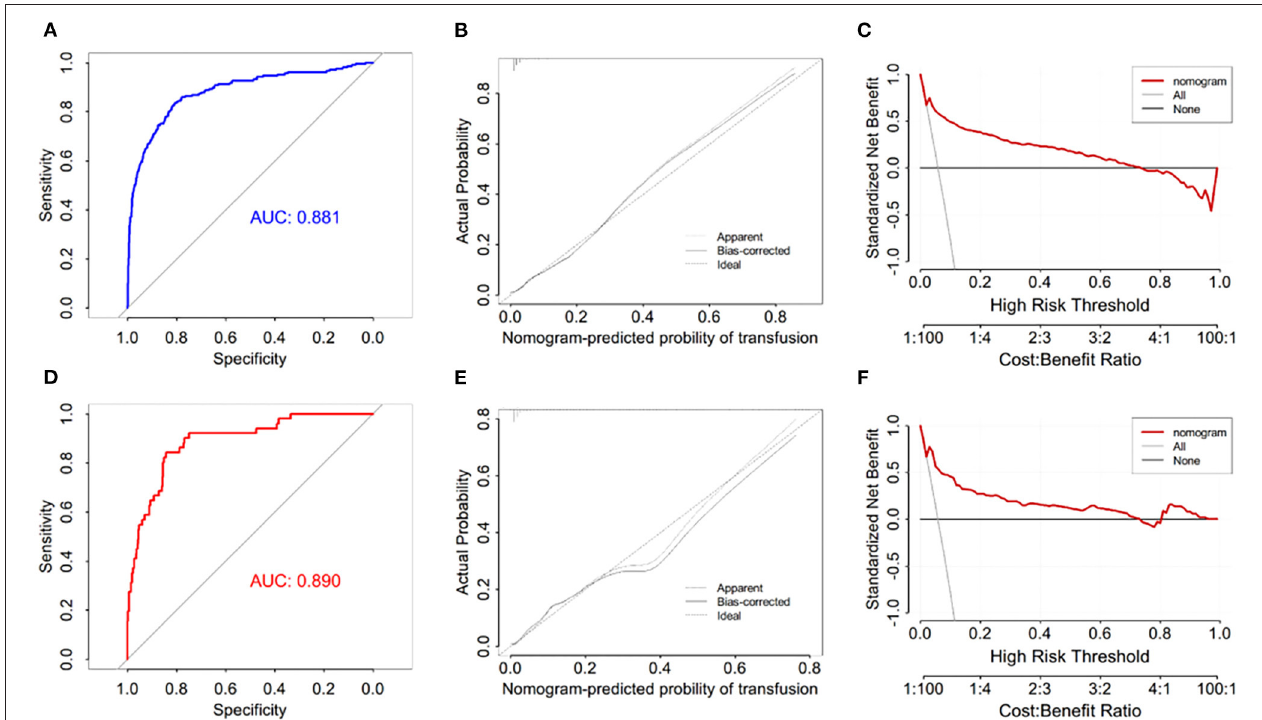
FIGURE 2 | (A) ROC curve in training set to evaluate prediction accuracy; (B) decision curve analysis in training set; (C) calibration curve in training set; (D) ROC curve in test set to evaluate prediction accuracy; (E) decision curve analysis in test set; (F) calibration curve in test set.